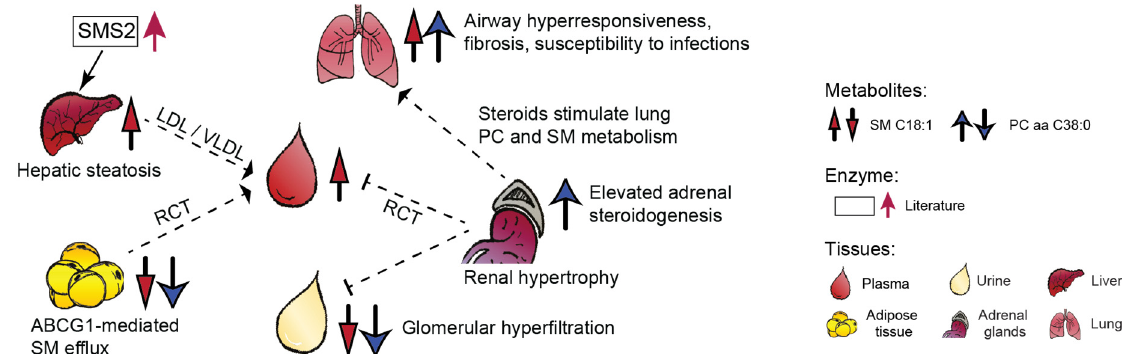
Figure 3. Organ-specific trends of SM C18:1 and PC aa C38:0 in a mouse model of diabetic nephropathy and potential interorgan crosstalk inferred from literature (interrupted lines, references in discussion). Abbreviations: ABCG1, ATP- binding cassette subfamily G member 1; RCT, reverse cholesterol transport; SMS2, sphingomyelin synthase 2; VLDL, very- low-density lipoprotein; LDL, low-density lipoprotein; SM, sphingomyelin; PC, phosphatidylcholine.